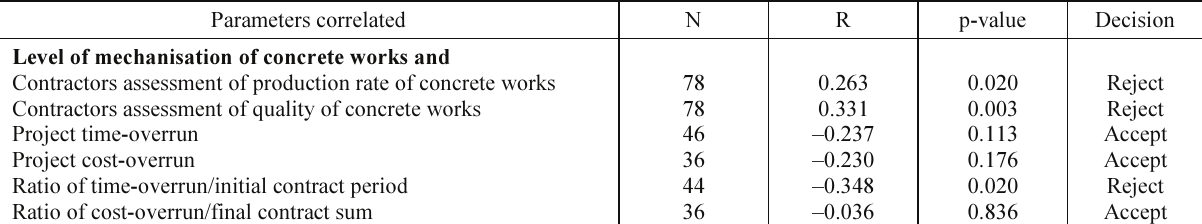
Table 11. Results of Spearman test of correlation between the level of mechanisation of concrete works and project outcome Parameters correlated N R p-value